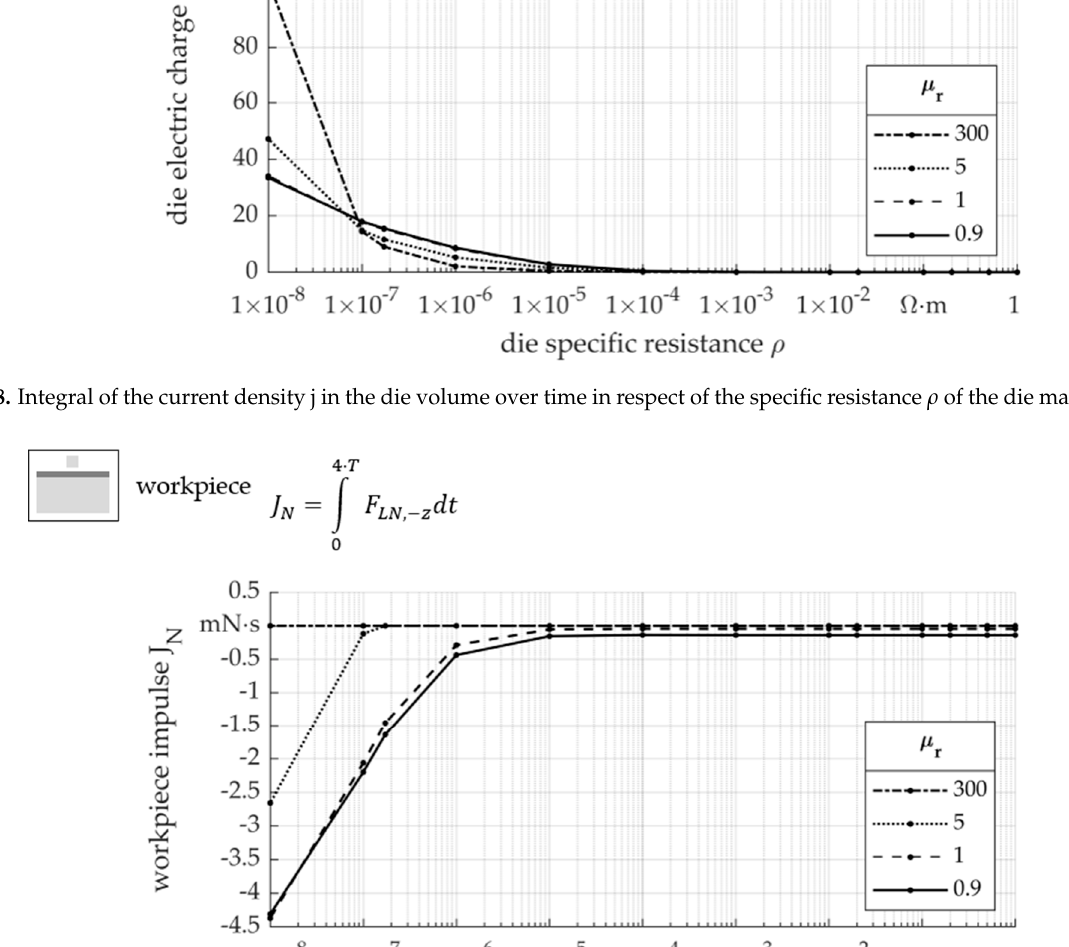
Figure 9. Integral of the negative force components over time in respect of the specific resistance 𝜌 of the die material